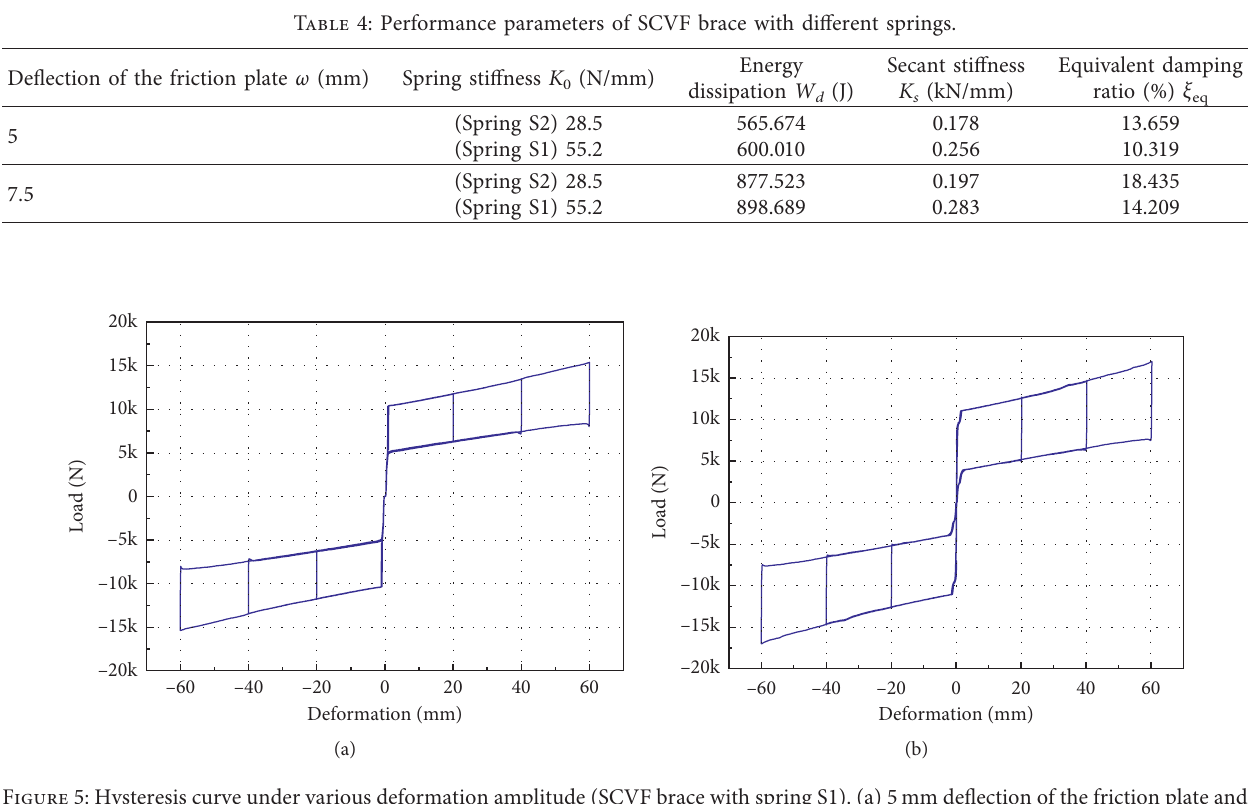
Figure 5: Hysteresis curve under various deformation amplitude (SCVF brace with spring S1). (a) 5mm deflection of the friction plate and (b) 7.5 mm deflection of the friction